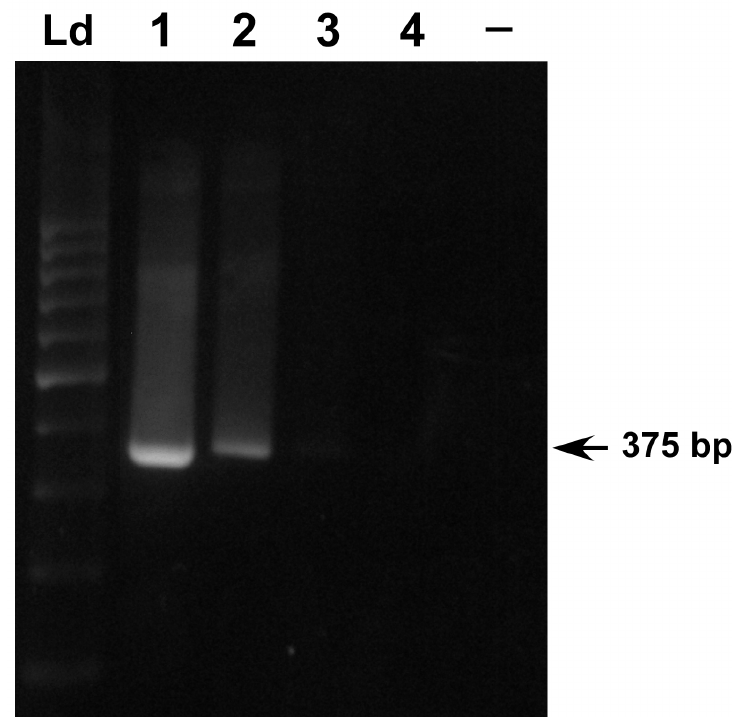
spp. DNA (Table I). According to the PCR-based